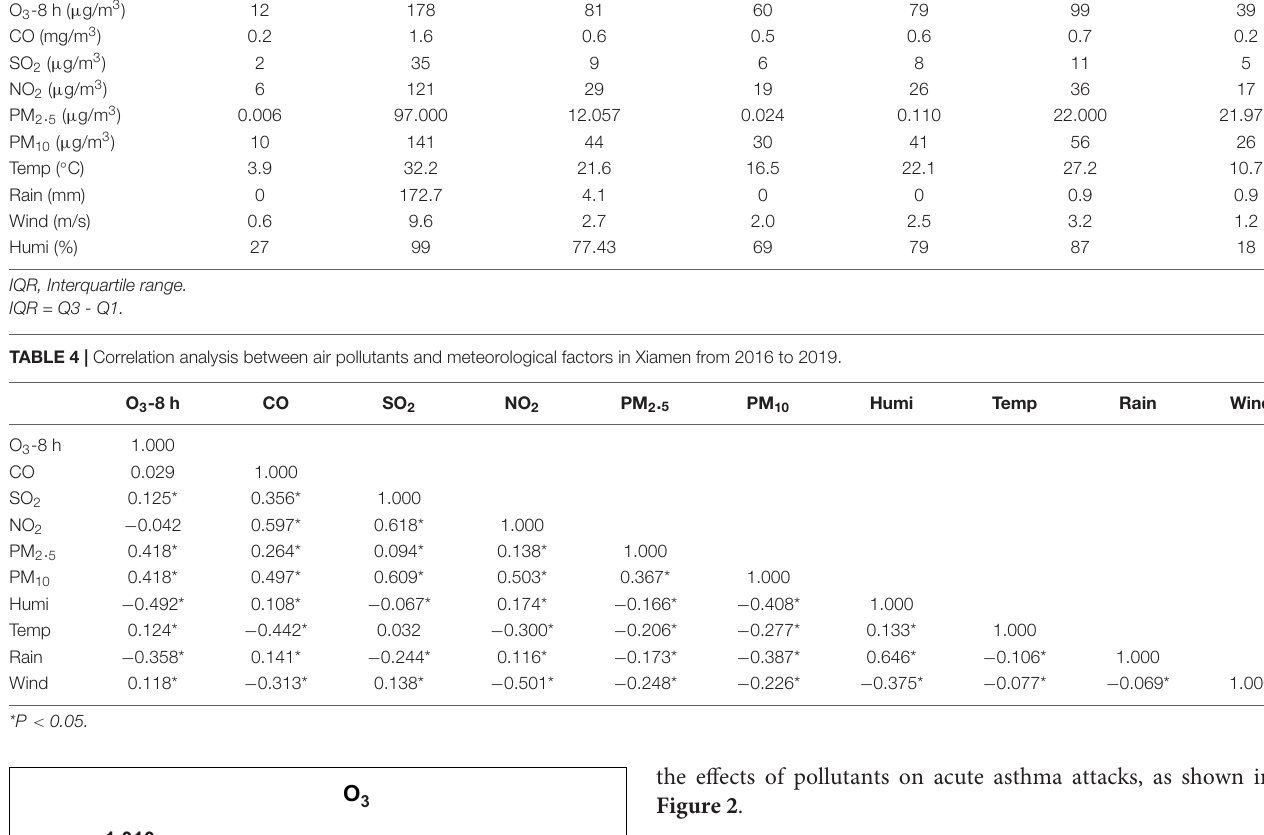
TABLE 3 | Characteristics of daily air pollutants and meteorological variables in Xiamen from 2016 to 2019. Mini Max Average